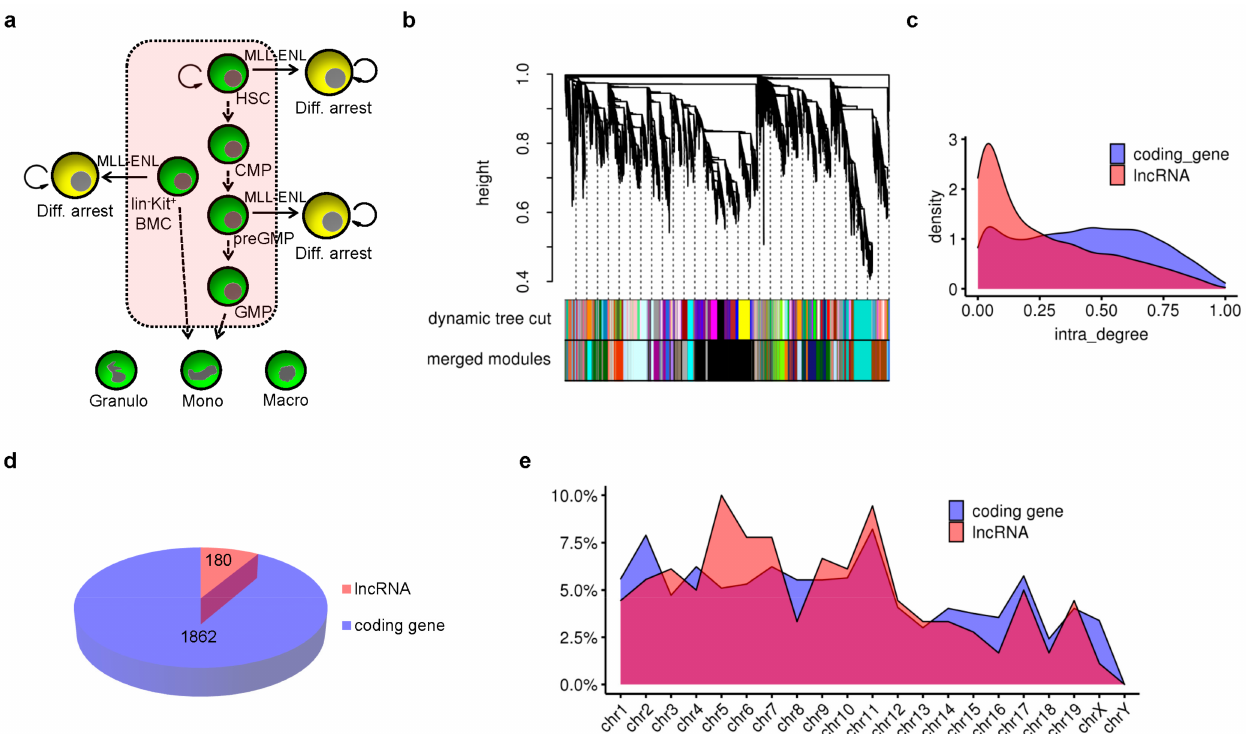
Figure 1. Potential key lncRNAs in the context of mouse myeloid differentiation. ( a ) All cell types involved in gene co- expression network analysis and their hierarchical differentiation relationship were shown. Diff. is short for differentiation. ( b ) Cluster tree and gene modules in gene co-expression network analysis. All genes were clustered into dynamic modules based on gene expression correlation, and dynamic modules with strong correlation between their eigengenes were merged to form final merged gene modules in gene co-expression network. ( c ) Distribution of intra-module degree for mRNA and lncRNA genes. ( d ) Total number of potential key mRNA and lncRNA genes with intra-module degree ranking top 25% in each module. ( e ) Distribution of these potential key lncRNA and mRNA genes across all